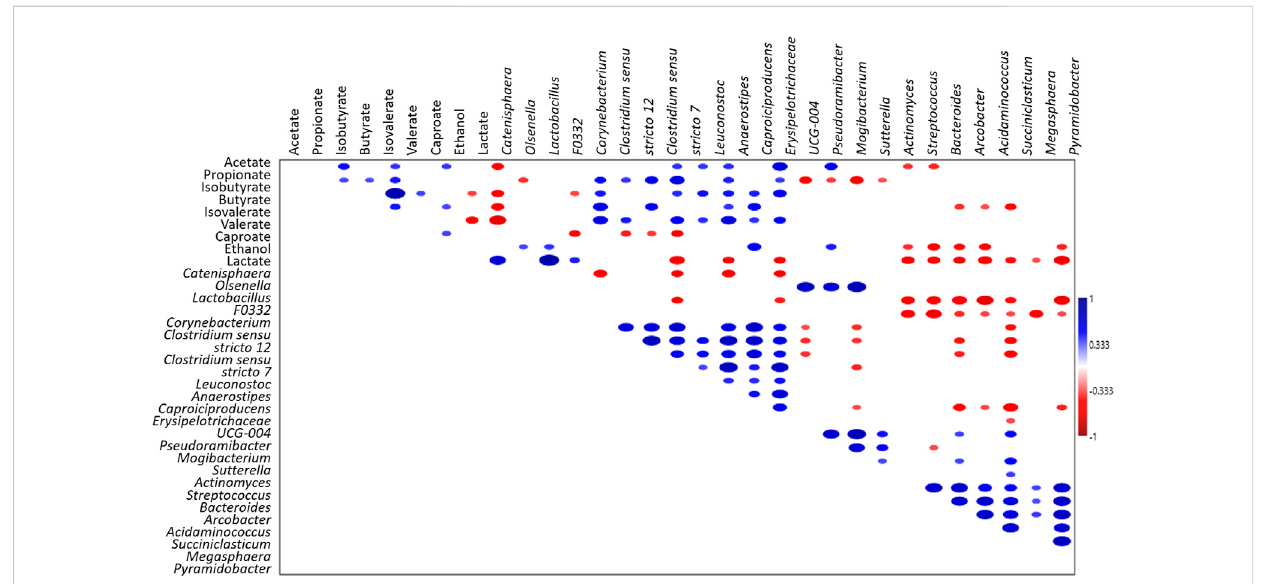
FIGURE 4 Spearman ’ scorrelationanalysisofmicrobiota(genera ≥ 5%inatleastonesample),S-andMCFAs(mgL -1 )andelectrondonors(mgL -1 )inallthetested reactors. Blue and red ellipses indicated signi fi cant positive and negative correlation ( p < 0.05), respectively. Colour saturation is proportional to the absolute correlation.